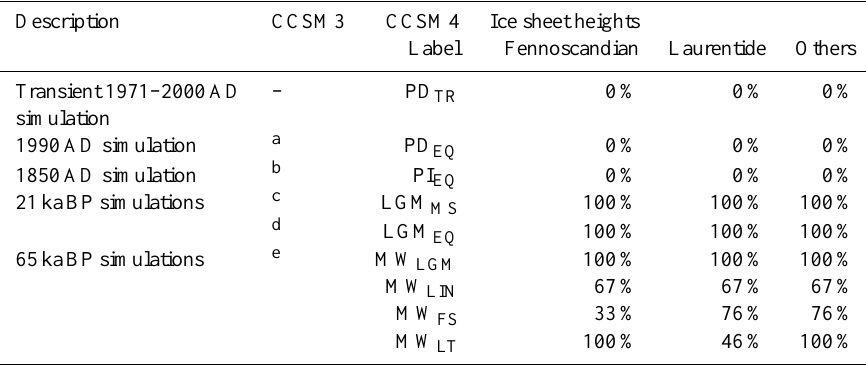
Table 1. Overview of the simulations for the two model versions and the ice sheet topographies applied in CCSM4. The monthly mean SST and sea ice data of the five CCSM3 simulations are used as inputs for the corresponding CCSM4 experiments. The MW simulation for CCSM3 uses the same topography as the LGM one and its SST and sea ice fields serve as input in all the CCSM4’s MW experiments – which differ only in their ice sheet topographies (see also Fig. 1 and text). The values for the ice sheet heights indicate how much of Peltier’s LGM–present-day topography changes are applied for the Fennoscandian, the Laurentide and all other (mainly Greenland and Antarctica) ice sheets.